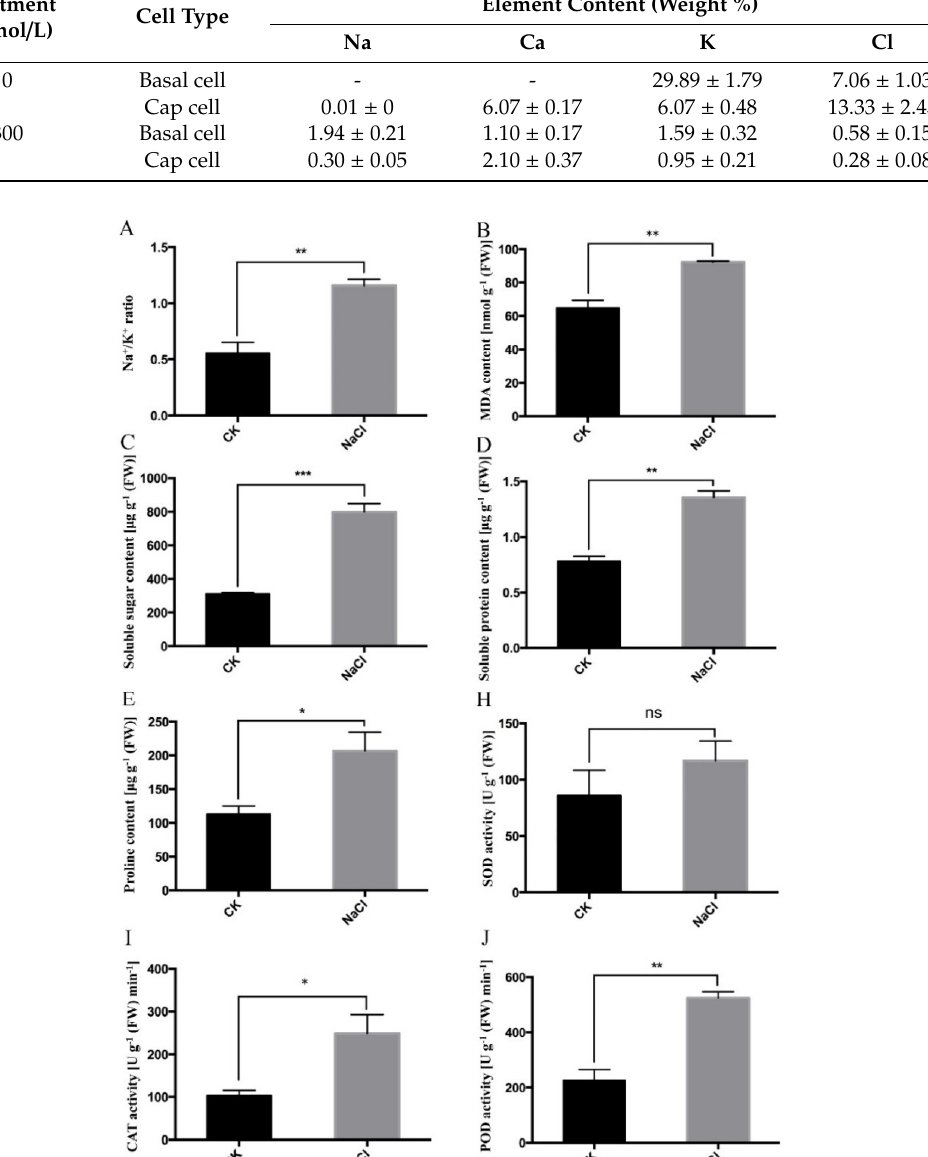
Figure 2. Biochemical parameters of leaf tissue in control group and 300 mmol/L NaCl-treated group (24 h), including Na + / K + ratio, malondialdehyde (MDA) content, soluble sugar content, soluble protein content, proline content, superoxide dismutase (SOD) activity, catalase (CAT) activity, and peroxidase (POD) activity. The data were obtained by averaging three biological replicates. The error bars represent ± SE. n = 3. *: p < 0.05, **: p < 0.01, ***: p < 0.001, ns: not significant.